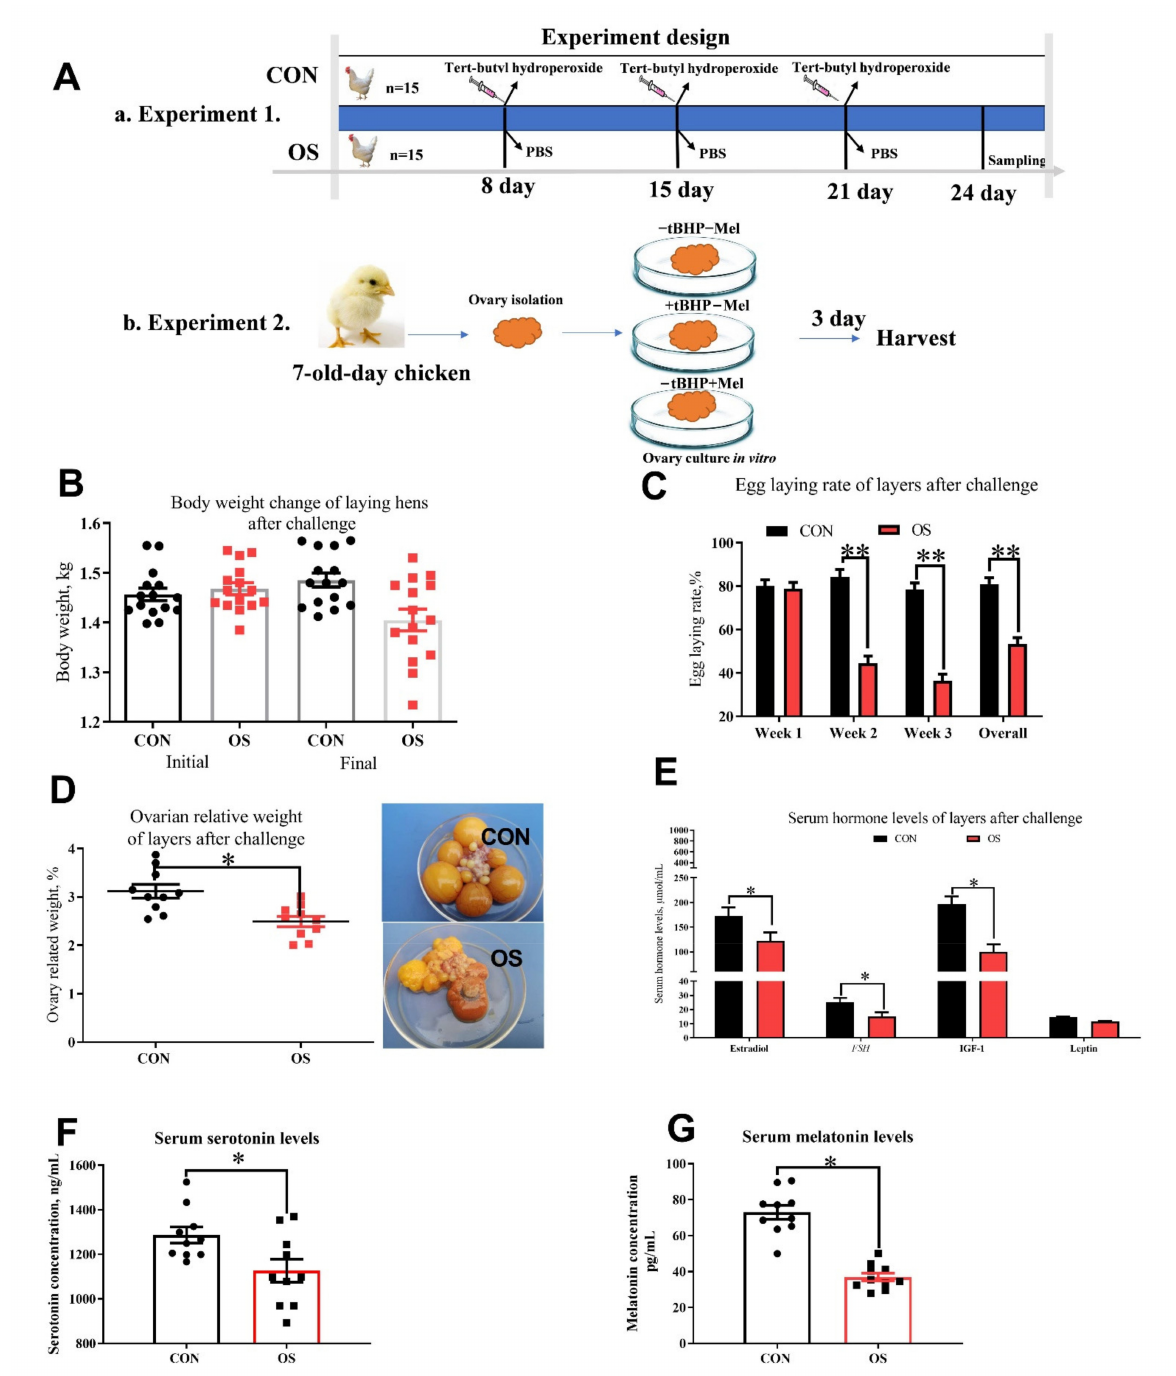
Figure 1. Oxidative stress (induced by tBHP) reduced egg-laying rate, ovary indices and serum hormone levels (Experiment 1). Data are means ± SEM represented by vertical bars or plot individual values ± SEM. ( A ) Schematic illustration of the experimental design. In Experiment 1, layers were fed the same basal diet for 24 days and with the tBHP (OS) or PBS (CON) injection at 9 AM of the d 8, 15, and 21. In Experiment 2, the ovaries of 7-day-old chickens are isolated for in vitro culture, and received different culture medium with 0 tBHP + 0 melatonin ( − tBHP − Mel), 50 µ mol/mL tBHP (+tBHP − Mel), and 50 µ mol/mL tBHP + 100 ng/mL melatonin (+tBHP + Mel). ( B ) Body weight. ( C ) Egg-laying rate after challenge. ( D ) Ovarian relative weight. ( E ) Serum reproductive and metabolism-related hormone levels. ( F ) Serum serotonin levels, and ( G ) Serum melatonin levels. FSH = follicle-stimulating hormone, IGF-1 = insulin-like growth factor-1, CON = same dosage of PBS, OS = 800 µ mol/kg BW of tBHP. Statistical significance was evaluated by t -test, * p < 0.05, ** p <